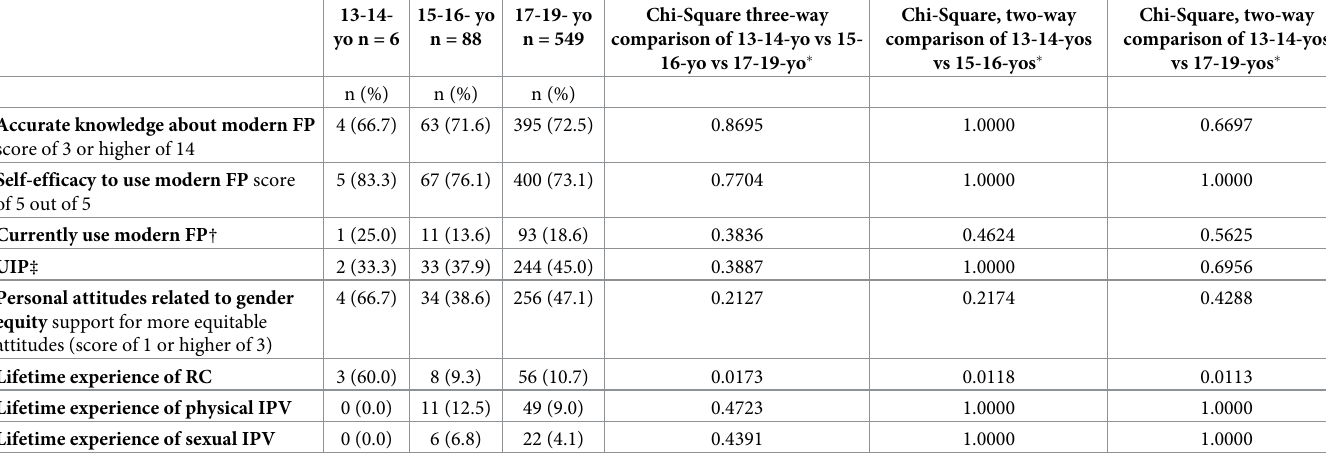
Table 3. Frequency of reproductive health, gender equity, and partner violence factors experienced among married AGYWs in Dosso region, Niger, by age group, among the parous